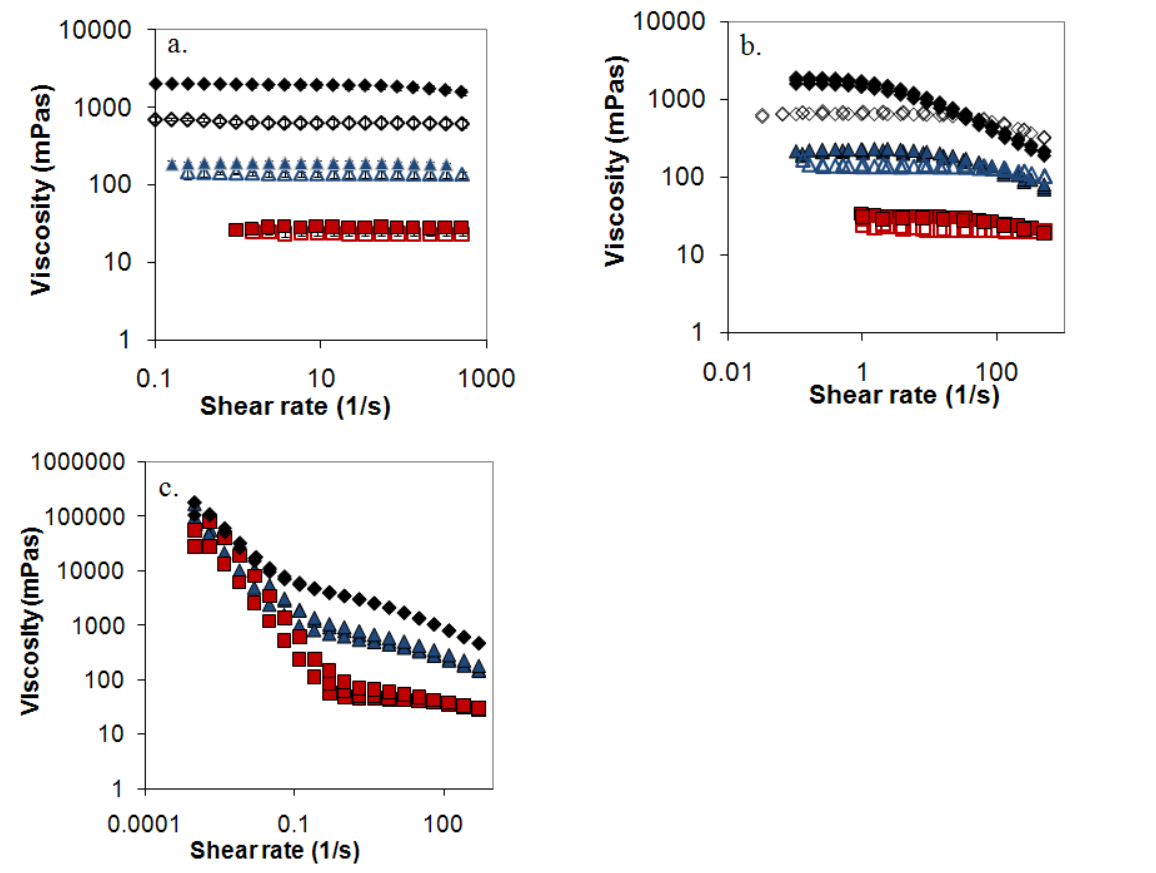
Figure 8. Flow curves (viscosity versus shear rate on a log-log scale) for the measured samples of: (a) dextran 50:50 and dextran 500, (b) PEO 80:20 and PEO 0.3 and (c) HPMC 60SH 90:10 for different reduced concentrations, c [ η ]=15 (black diamonds), c [ η ]= 10 (blue triangles) and c [ η ]=5 (red squares). Filled symbols represent mixed samples and open symbols nonmixed